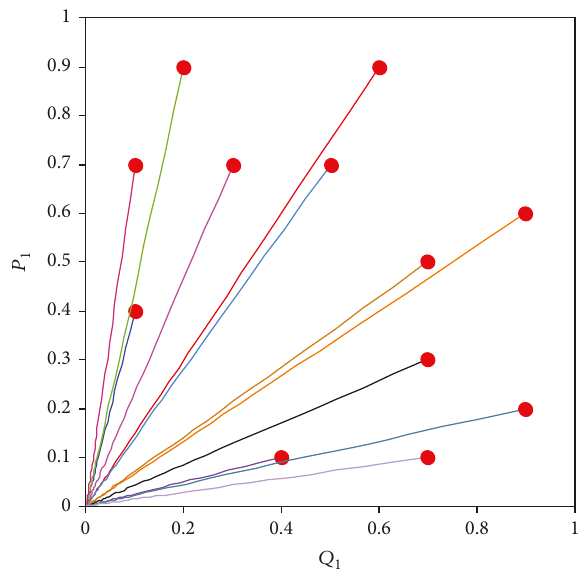
Q Figure 5: P 1 and 1 during the learning process of EAQR in Case 1 ( ε = 0 ).